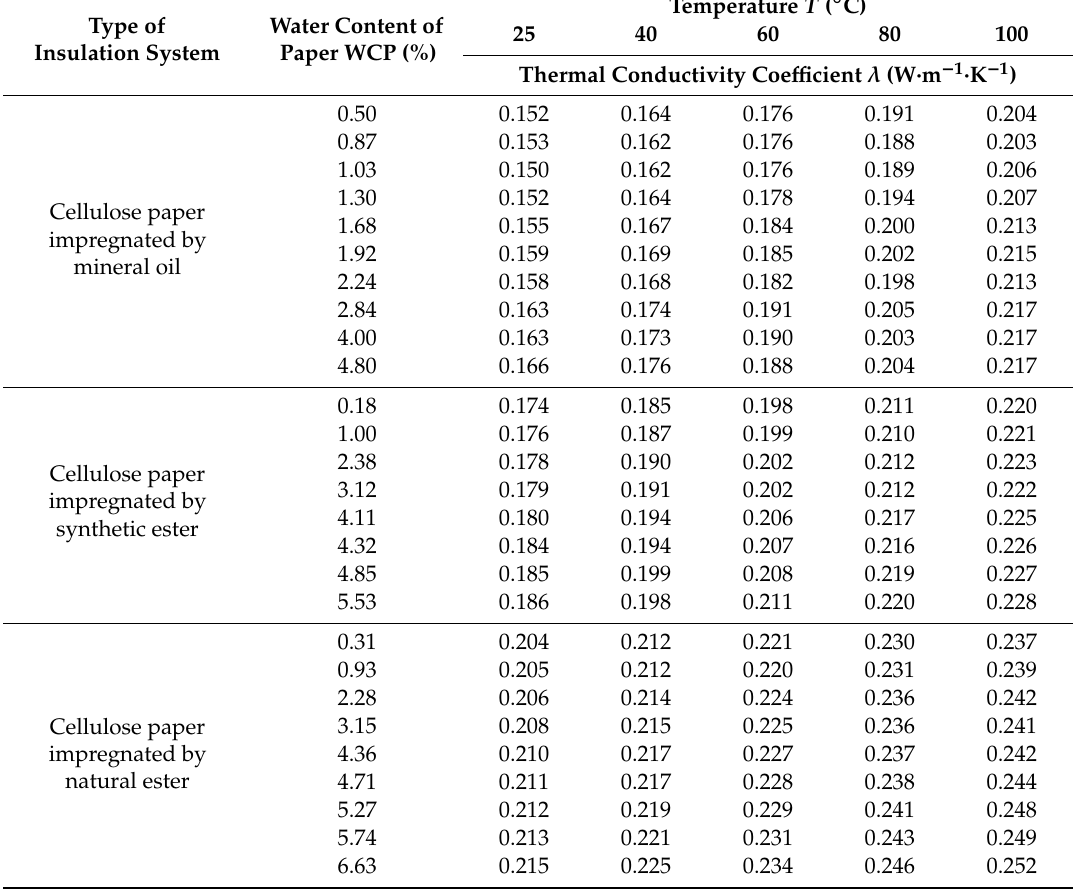
Table 3. Thermal conductivity coe ffi cient λ of cellulose paper impregnated by various dielectric liquids depending on the water content of paper WCP, at di ff erent temperatures T